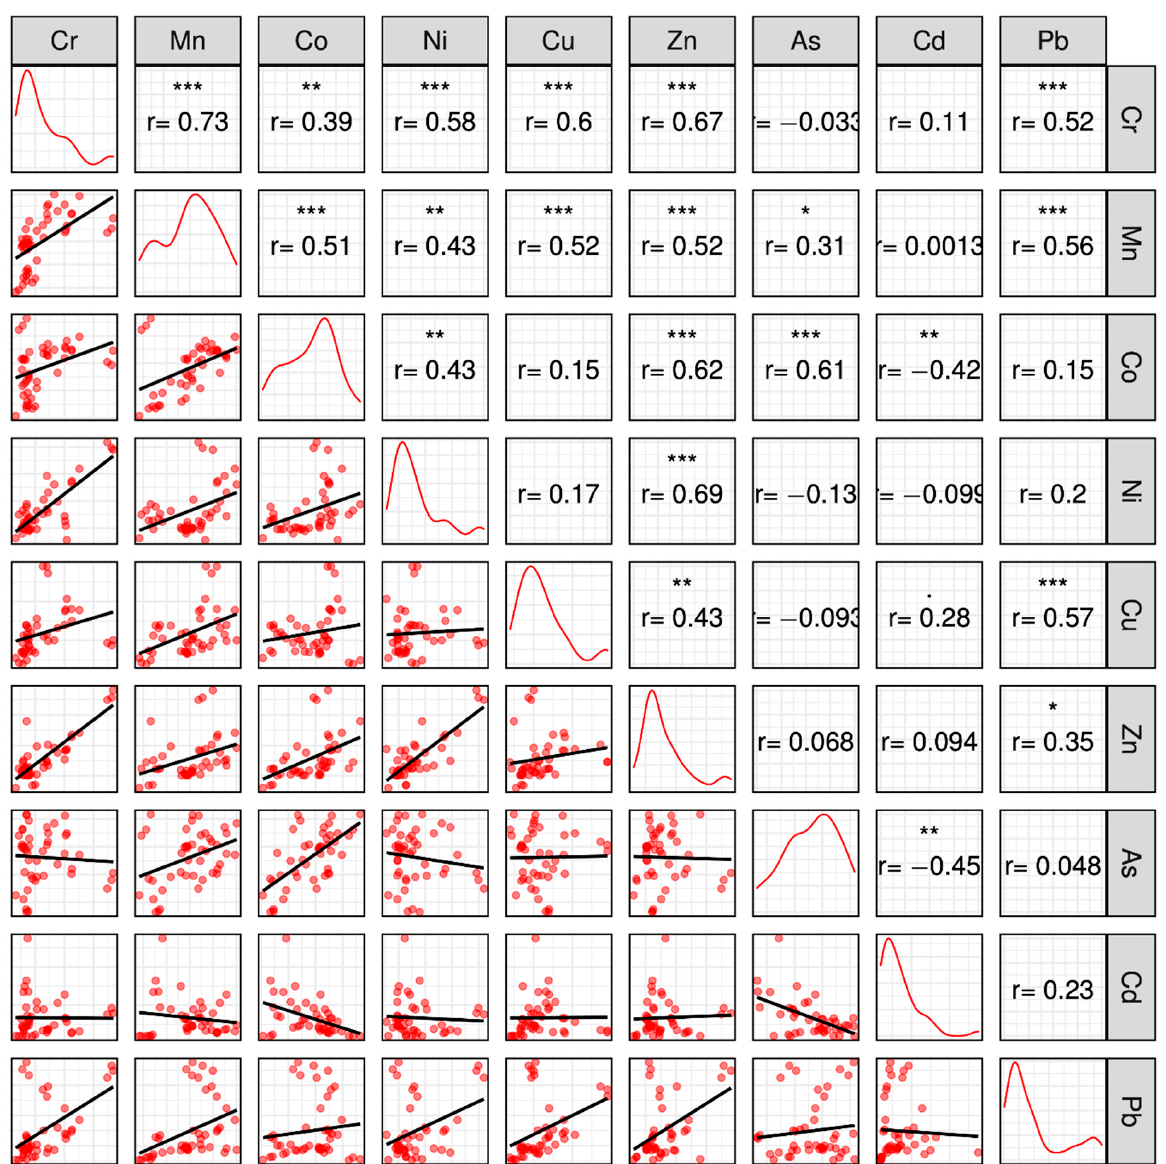
Figure 3. Correlation matrix of toxic metal concentrations in road dust of Mymensingh City. The values in the upper and lower matrices are Spearman’s rank correlation coefficient ( ρ ) and metal concentrations, respectively. Spearman’s rank correlation coefficient values ( ρ ) with *, **, and *** denote significant at 95%, 99%, and <99% levels of significance. The diagonal matrix (density plots) shows the distribution of data.